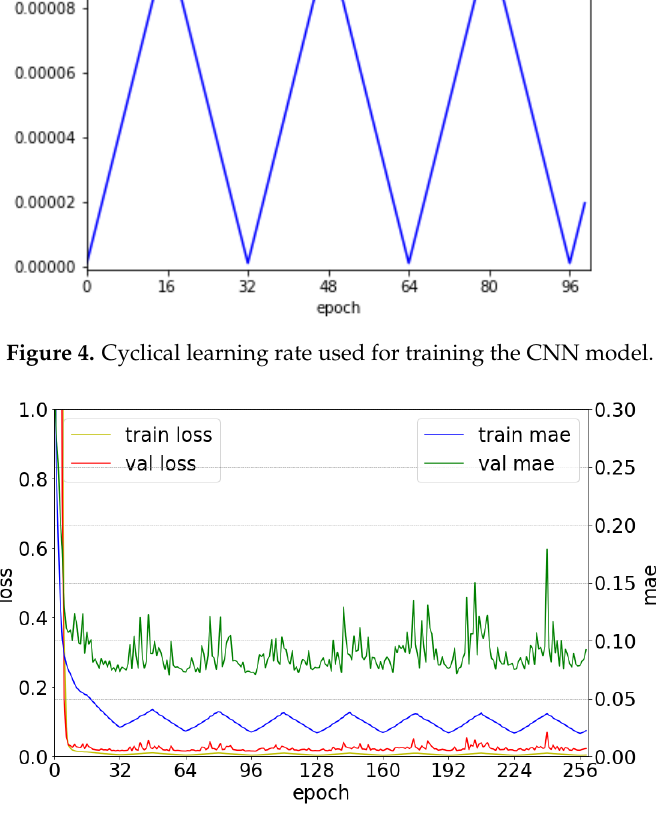
Figure 5. Variations of loss and mean absolute error (MAE) depending on the epochs for the training and validation